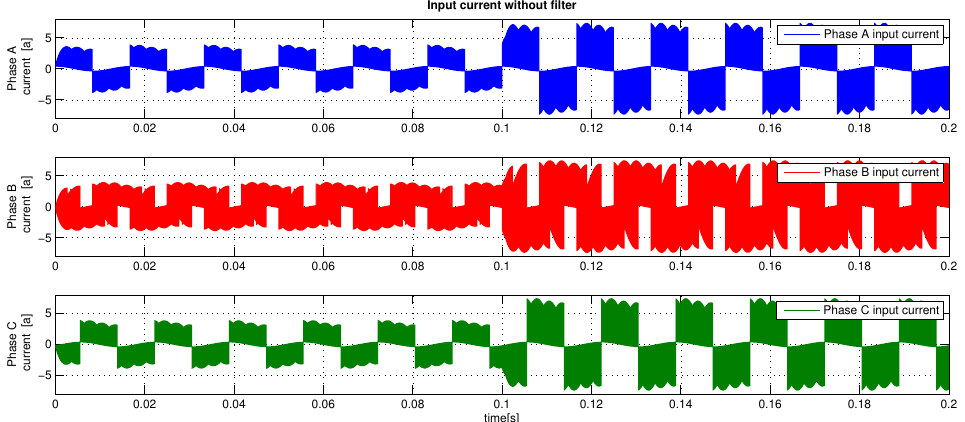
Figure 9. Input current without filter.